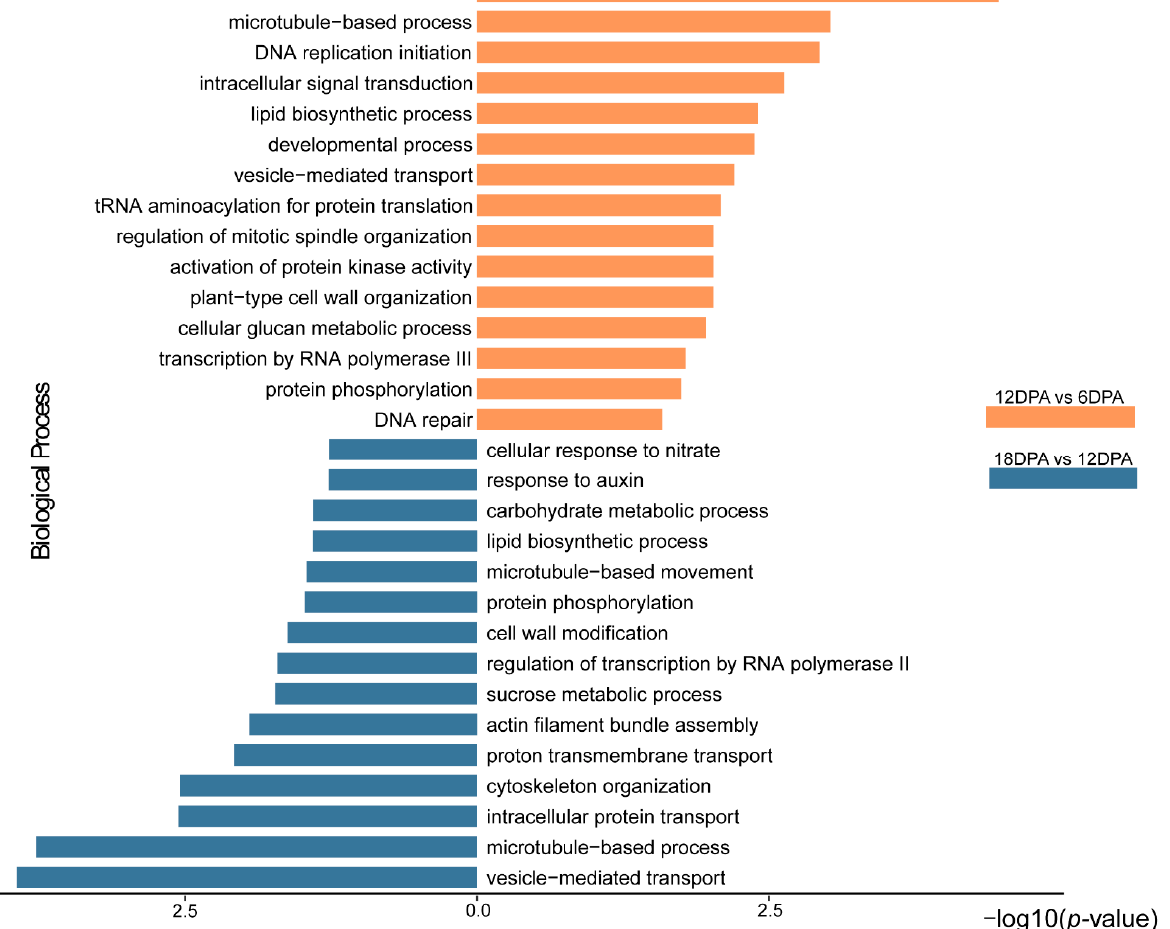
Figure 4. Gene ontology enrichment analyses of the genes differentially expressed between Gossy- pium stocksii fibers of 6, 12 and 18 DPA.